Question: Sum up the contents of this chart in one sentence.
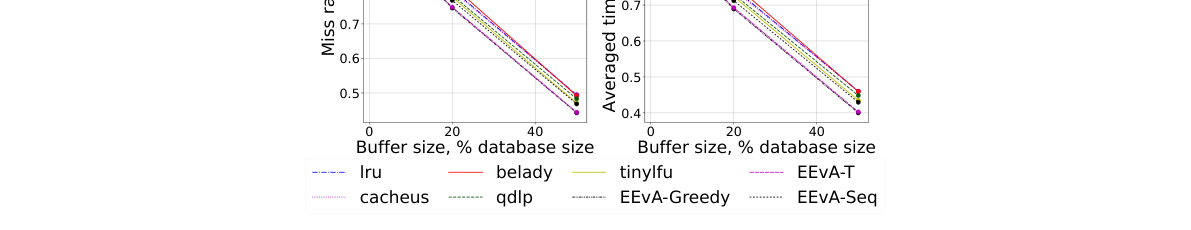
Answer: Comparison in the scenario with rare scan-type queries. The lower the miss rate and averaged time costs, the better the performance is. EEvA-based algorithms show a superior performance over the competitors wrt both metrics.